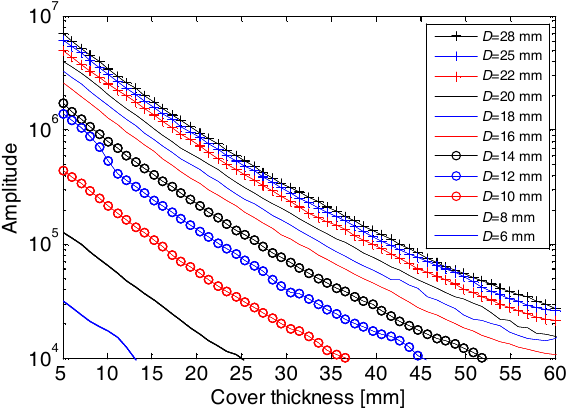
Figure 5. Variation of the EMI peak amplitudes versus the cover thickness and rebar diameter when the coils are right above the rebars during the calibration experiment.